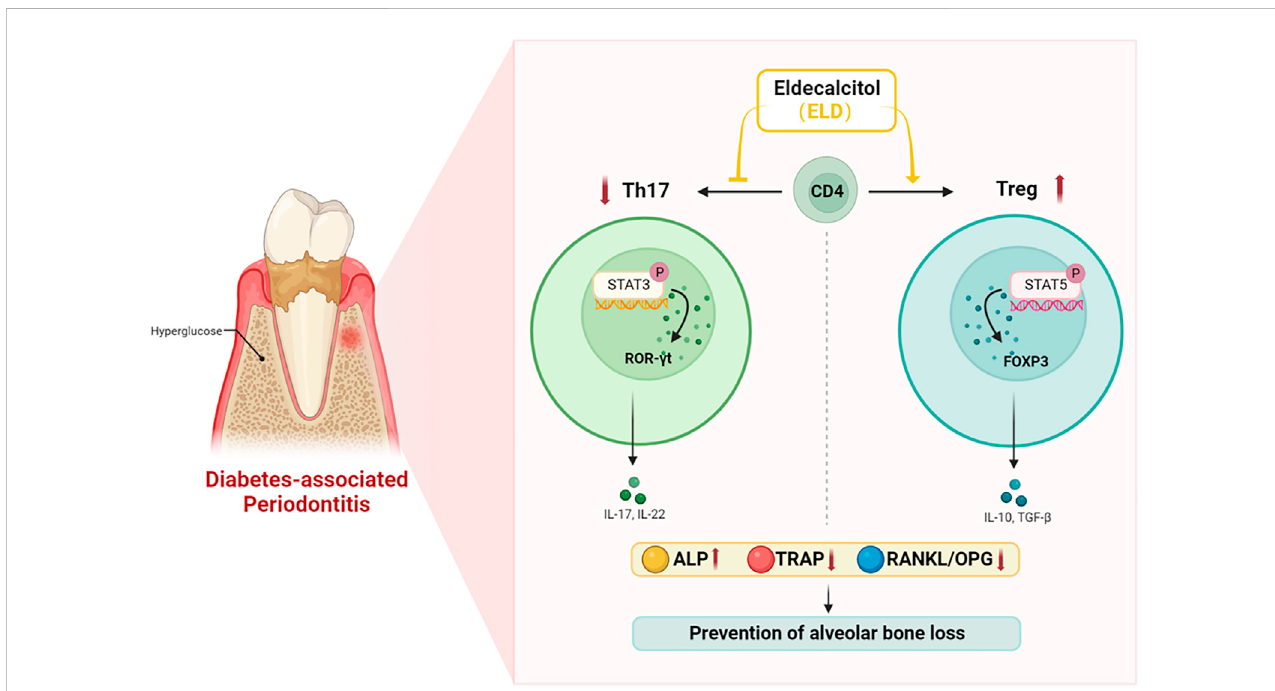
FIGURE 8 ELD effectively prevented alveolar bone loss by partially correcting the imbalance in Th17/Treg cells in DPD via the STAT3/STAT5 signal. ELD prevented alveolarbonelossinDPDbypartiallycorrectingtheimbalanceinTh17/Tregcells.OnepossibleactionmechanismmaybethatELDcorrectedtheimbalancein Th17/Treg cells by the STAT3/STAT5